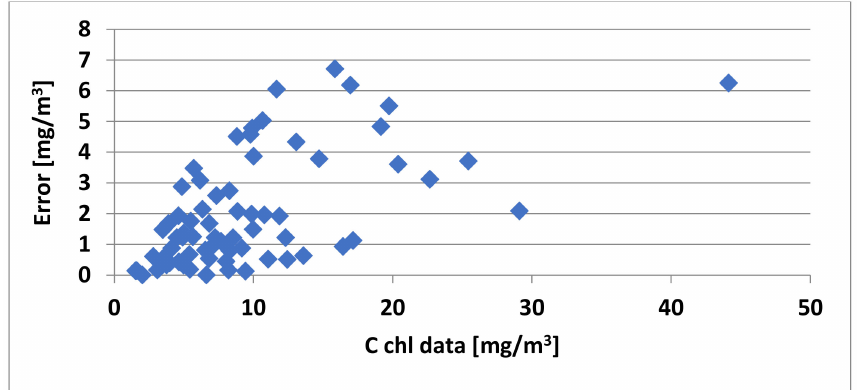
Figure 22. Model errors for chlorophyll a versus measurement data.